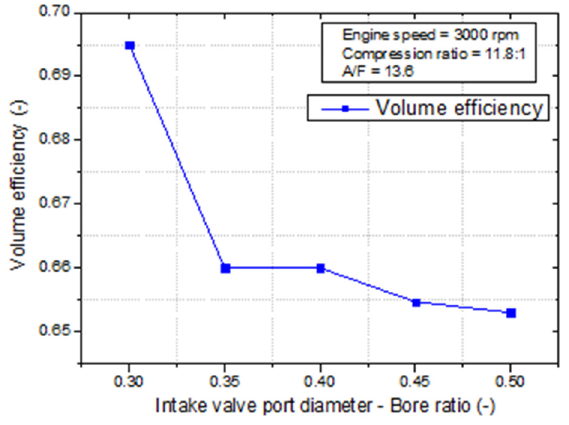
Figure 4. Volume efficiency versus IPD/B.